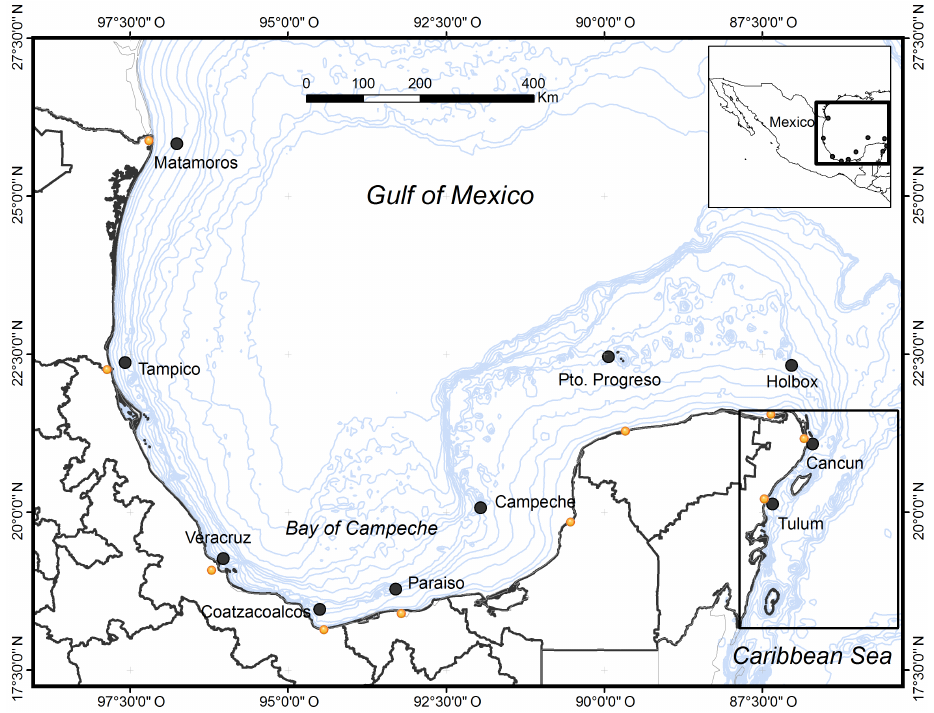
Figure 1. Study area with the analysed nodes (black dots) located in the GoM and the Mexican part of the western Caribbean Sea (Cancun and Tulum). Yellow dots indicate the location of nearby